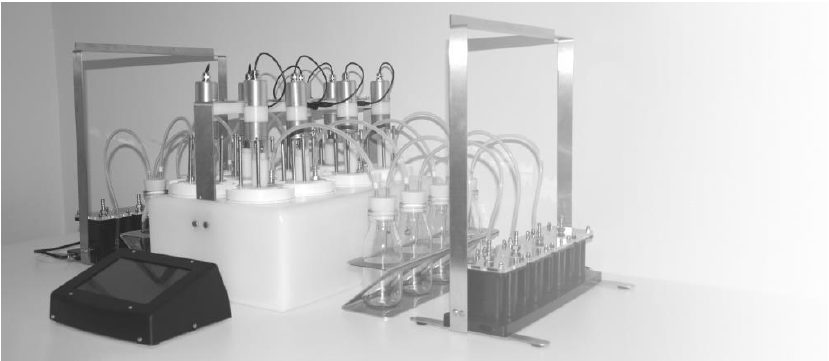
Figure 1. CJC biomethane potential system (courtesy of CJC labs).